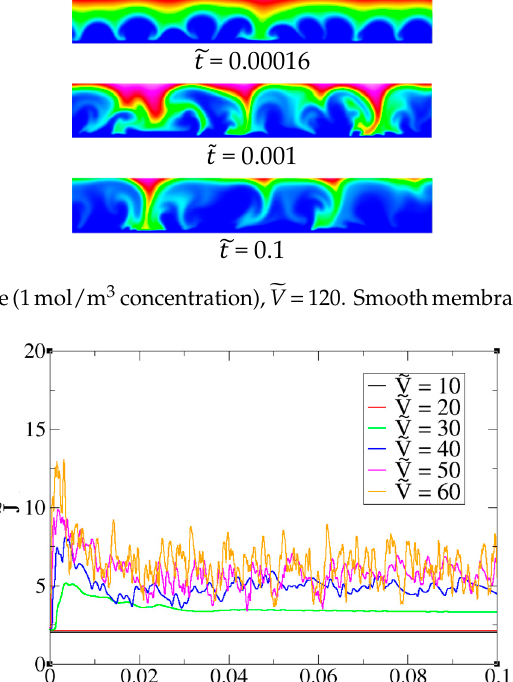
Figure 8. Baseline 2-D case. Area-averaged current density for the smooth membrane .